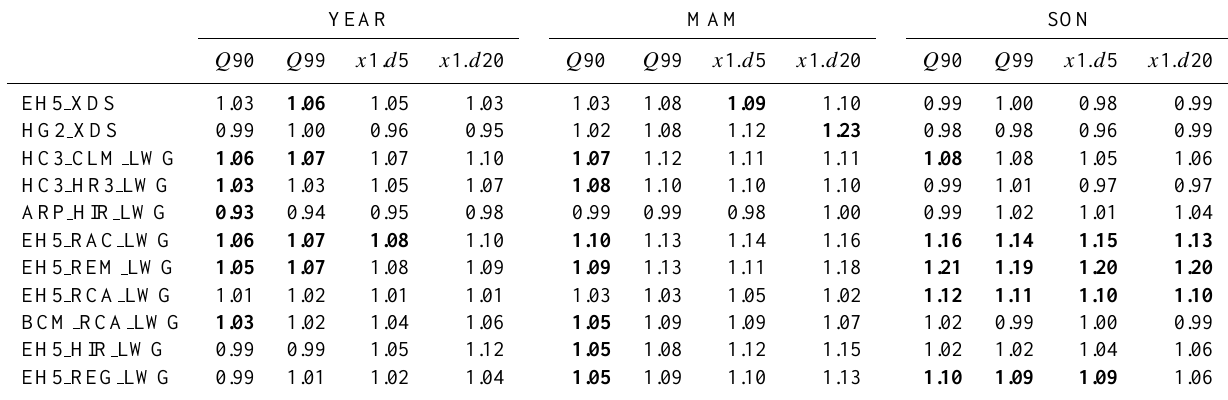
Table 4. Ratio between scenario and reference simulations for the 90th and 99th percentiles as well as for the 5- and 20-yr return values. 24-h precipitation events averaged over the Lech catchment are